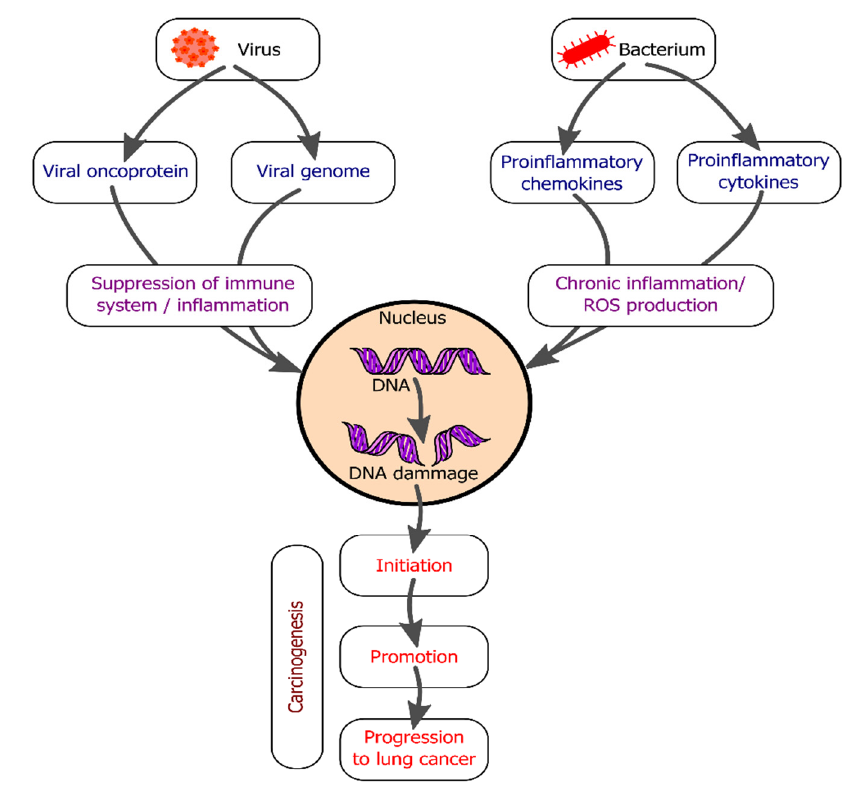
Figure 2. Overview of the role of bacteria and viruses in the development of lung cancer.